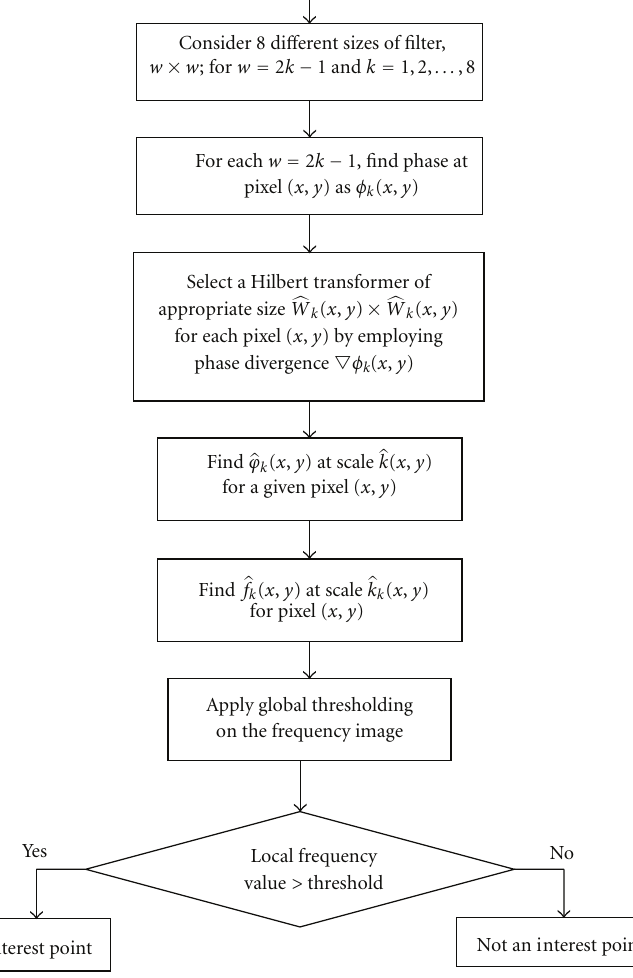
Figure 1: Block diagram of the proposed